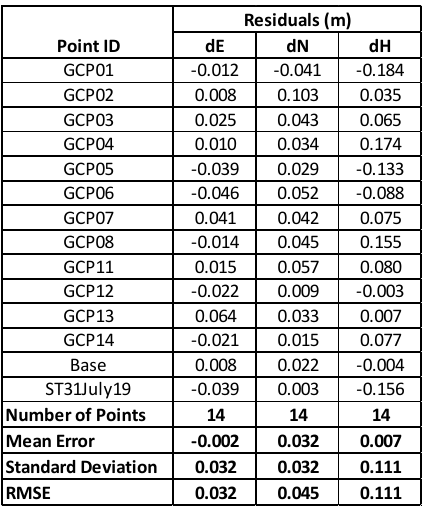
Table 2: CalQC Checkpoint Residuals, Flight 2